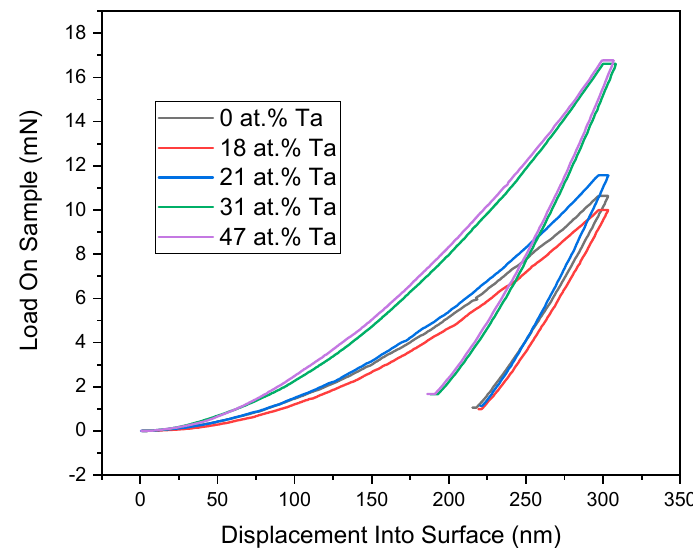
Figure 4. Nanoindentation curves of deposited films.